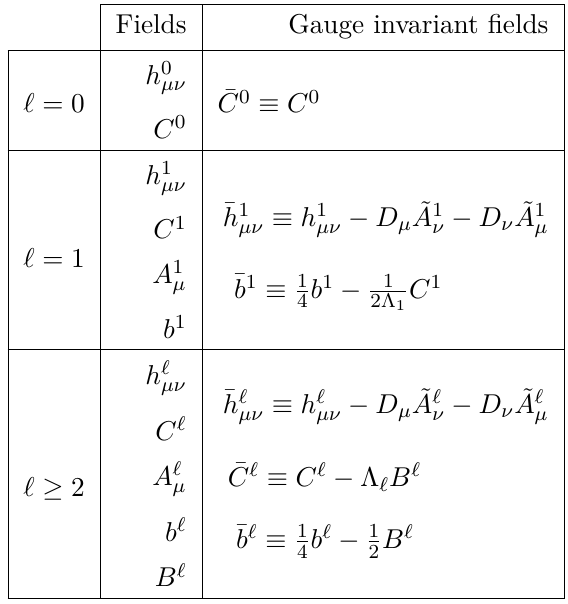
Table 5. Fields and gauge invariant combinations at linear order. For ‘ = 0 there is only one gauge invariant field and h 0 carries trivial harmonic index). To construct gauge invariant combinations for ‘ > 0 , one needs to introduce the auxiliary field ˜ A 1 ˜ A ‘ ≡ A ‘ − D µ B ‘ / 2 (then δ µ µ